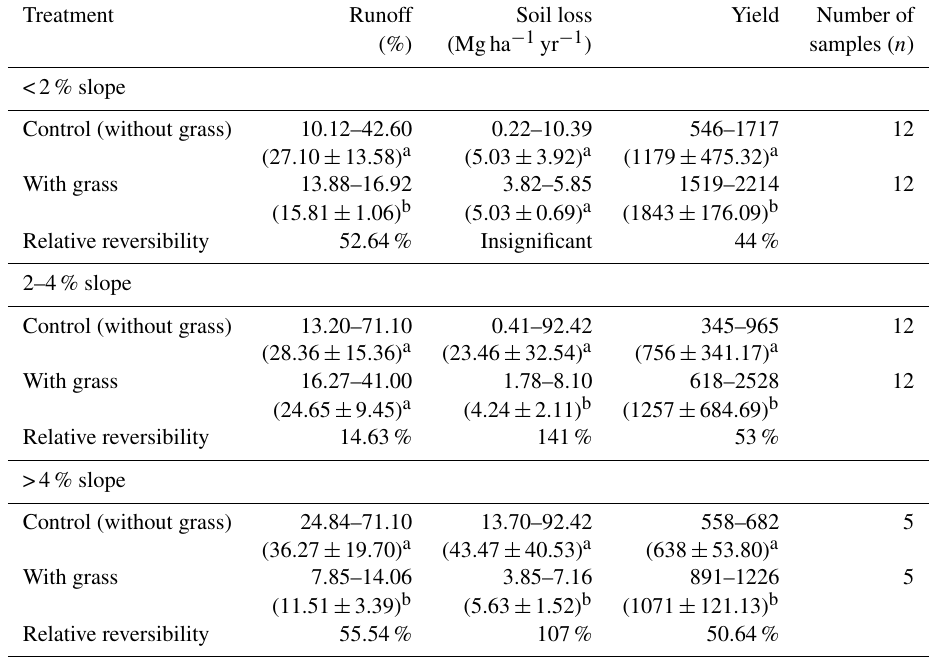
Table 5. Relative merits of contour grass barrier (CGBs) in different land slopes. Treatment